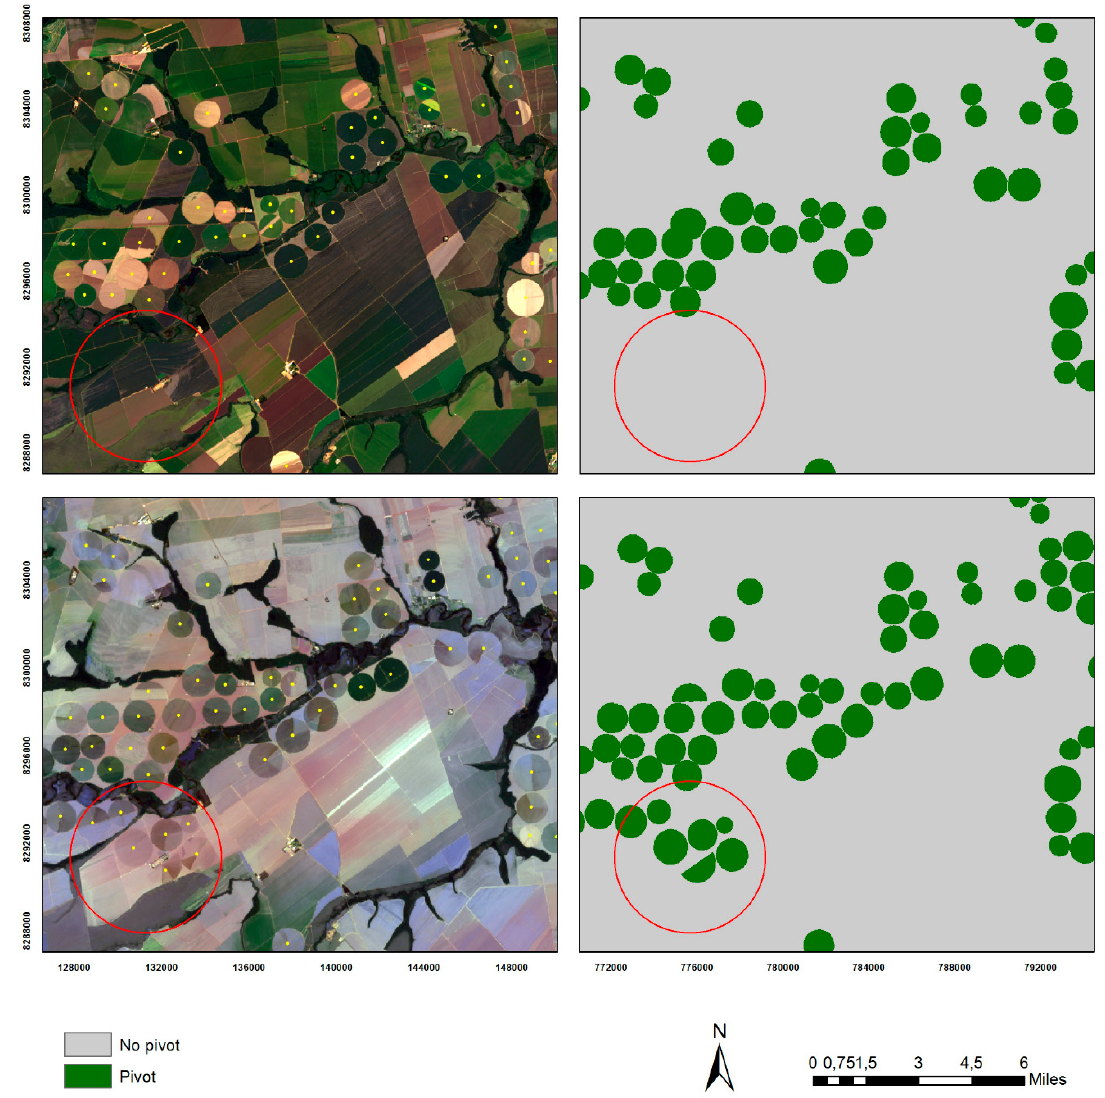
Figure 3. Change of center pivots in short time, requiring adjustments and corrections in the database for the elaboration of terrestrial truth images.